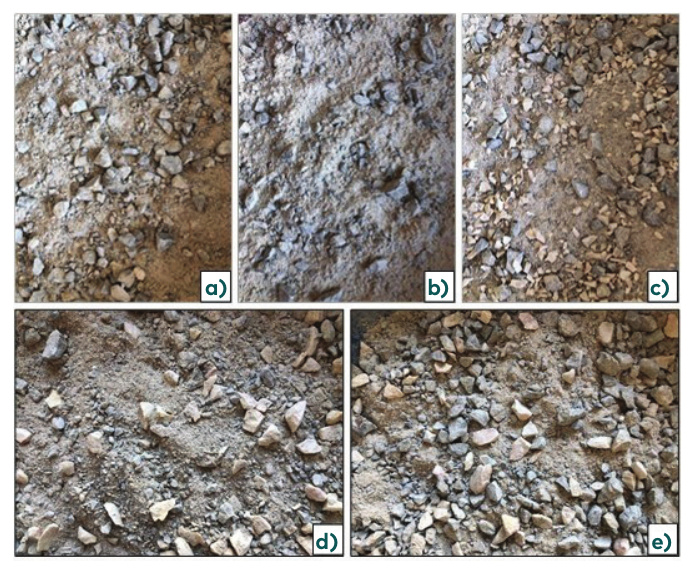
Figure 9. Photographs of prepared five